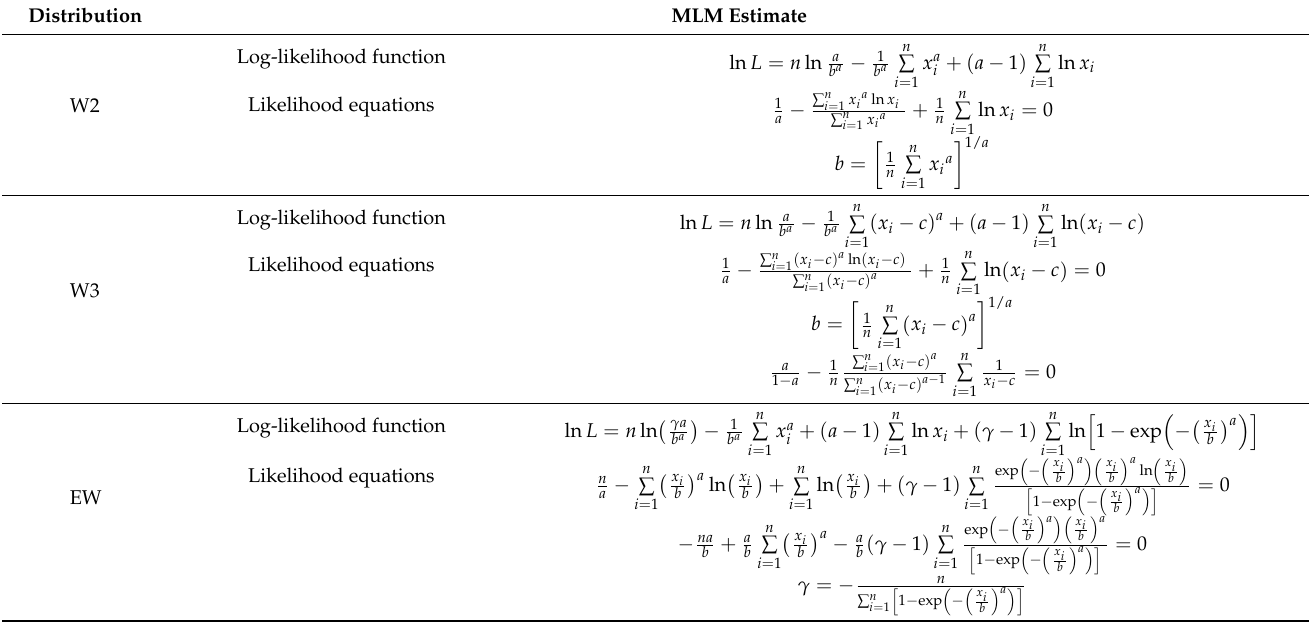
Table 4. Log-likelihood functions and likelihood equations of selected probability